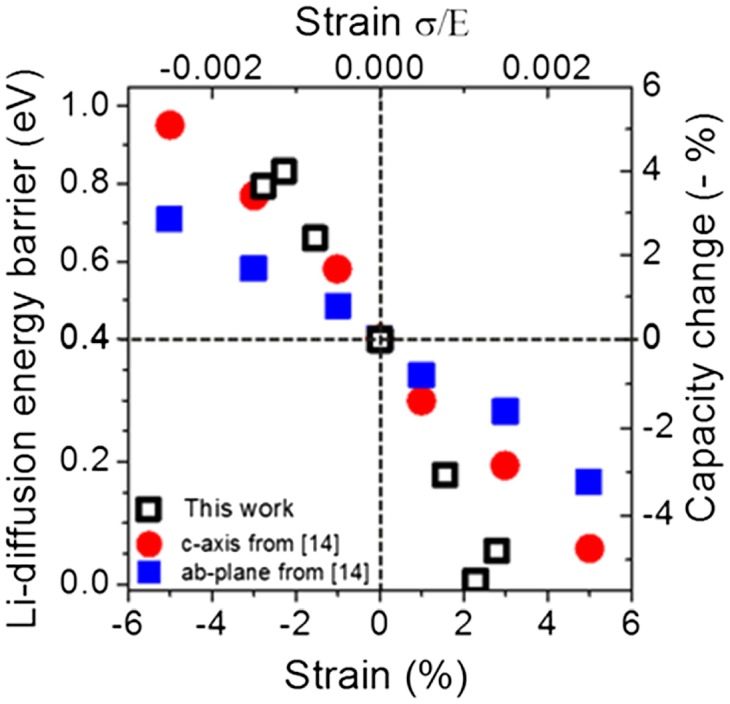
Relationship between the Li-diffusion energy barrier as a function of strain applied according to the simulation from [14] (red circles and blue squares). The open black circles represent the average change in capacity obtained from our flexible thin-film battery bending experiments as a function of strain (stress).